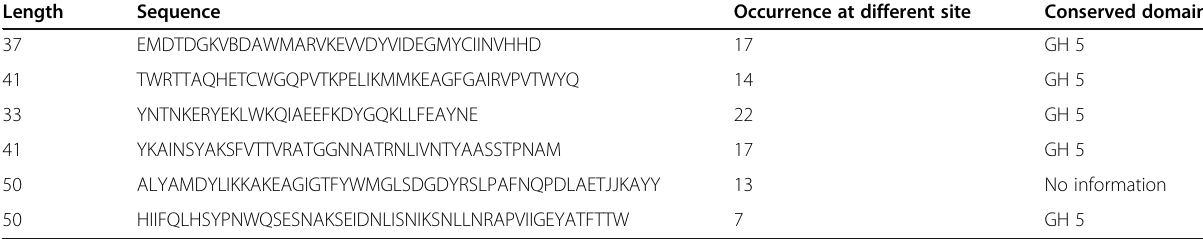
Table 3 The six motifs of the GH5-cellulases family from uncultured microorganisms found among the 27 sequences Length Sequence Occurrence at different